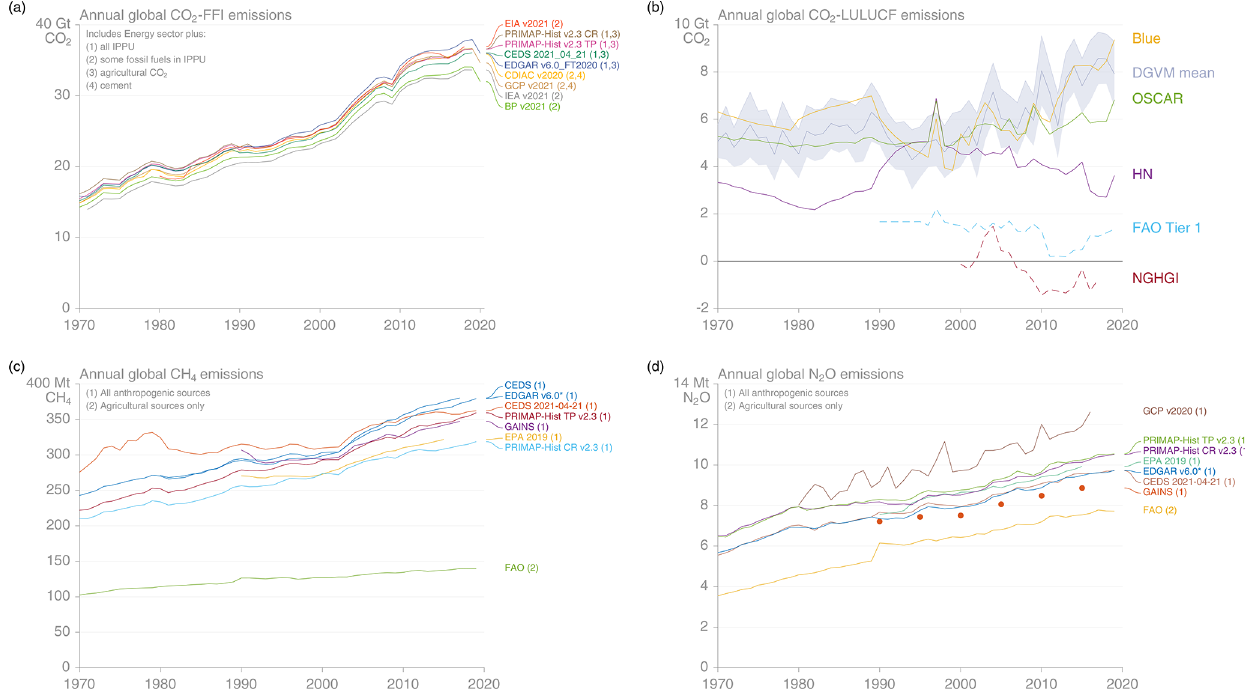
Figure 1. Estimates of global anthropogenic GHG emissions from different data sources for 1970–2019. (a) CO 2 FFI emissions from EDGAR – Emissions Database for Global Atmospheric Research (this dataset) (Crippa et al., 2021), GCP – Global Carbon Project (Andrew and Peters, 2021; Friedlingstein et al., 2020), CEDS – Community Emissions Data System (Hoesly et al., 2018; O’Rourke et al., 2021), CDIAC Global, Regional, and National Fossil-Fuel CO 2 Emissions (Gilfillan et al., 2020), PRIMAP-hist – Potsdam Real-time Integrated Model for probabilistic Assessment of emissions Paths (Gütschow et al., 2016, 2021b), EIA – Energy Information Administration Interna- tional Energy Statistics (EIA, 2021), BP – BP Statistical Review of World Energy (BP, 2021), and IEA – International Energy Agency (IEA, 2021a, b); IPPU refers to emissions from industrial processes and product use. (b) Net anthropogenic CO 2 -LULUCF emissions from